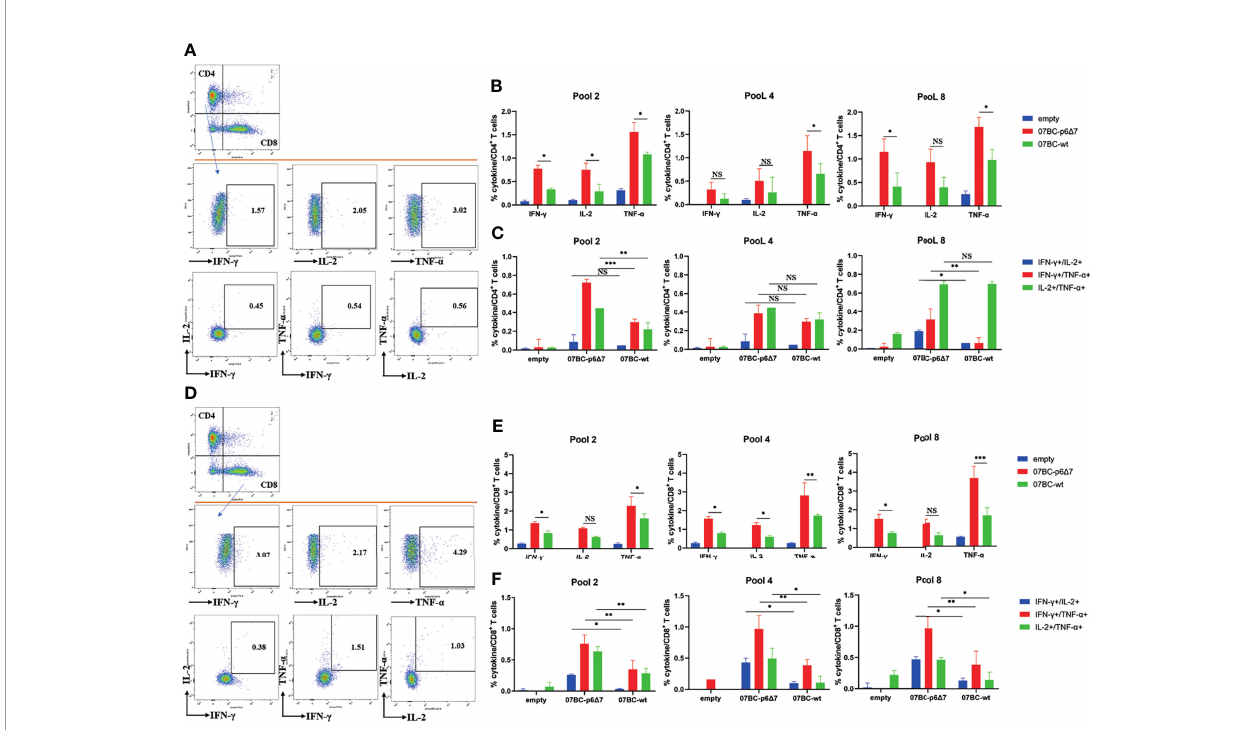
FIGURE 4 | Assessment of Gag-speci fi c cellular immunity elicited by Ad2 vaccine through intracellular cytokine staining (ICS) assay. The ability of polyfunctional CD4 + and CD8 + T-cell populations from immunized mice to secrete IFN- g , TNF- a , and IL-2 cytokines in response to Gag peptide pools stimulation was assessed. The background-subtracted median responses (n = 5) in BALB/c mice following vaccination are shown. Gating strategy for fl ow cytometric scatter plots to analyze the frequency of the single or multiple cytokine(s)-positive CD4 + (A) or CD8 + (D) T cells. Frequencies of CD4 + (B) or CD8 + (E) T cells secrete IFN- g , TNF- a , and IL-2 cytokines speci fi c to various Gag antigens after adenoviral-based immunization. Further analysis was performed to show subpopulations of double cytokines- secreting CD4 + T cells (C) or CD8 + T cells (F) . Data were expressed as mean ± SEM, and p-values of less than 0.05 were deemed statistically signi fi cant.*p < 0.05; **p < 0.01; ***p < 0.001; NS, no signi fi